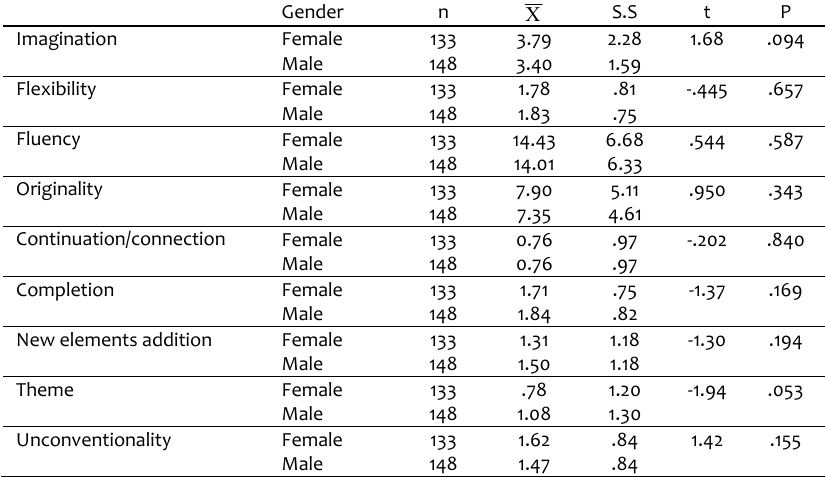
Table 2. T-test results associated with creativity scale sub-dimensions according to preschool children's gender